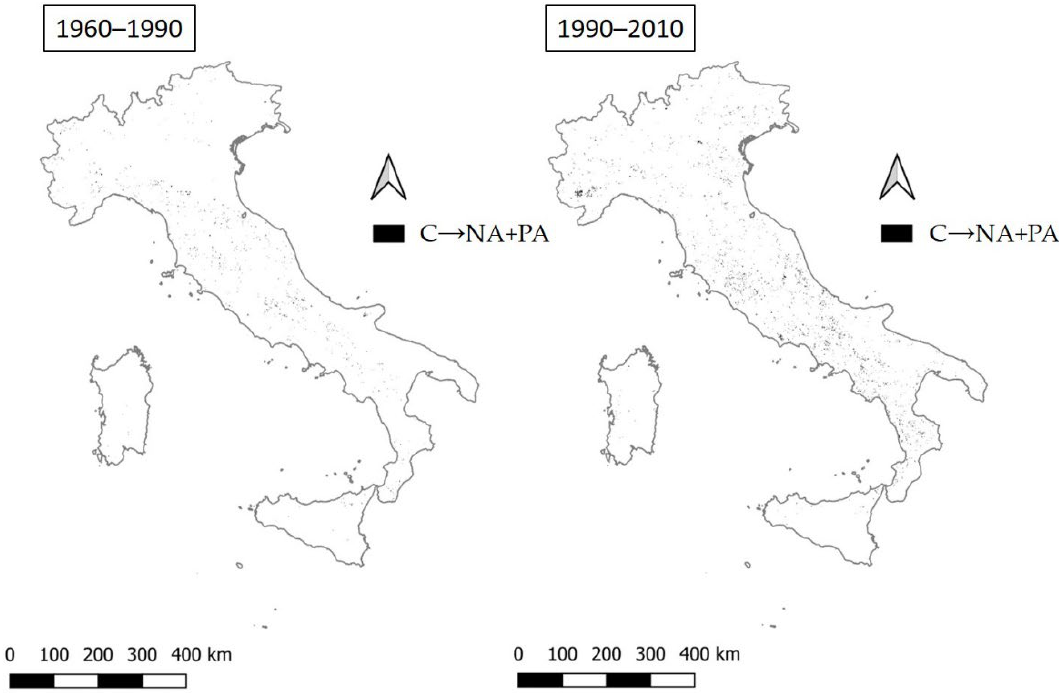
Figure 12. The transition from critical to not affected and potentially vulnerable areas (C → NA+PA) in the two time intervals (1960–1990 and 1990–2010).